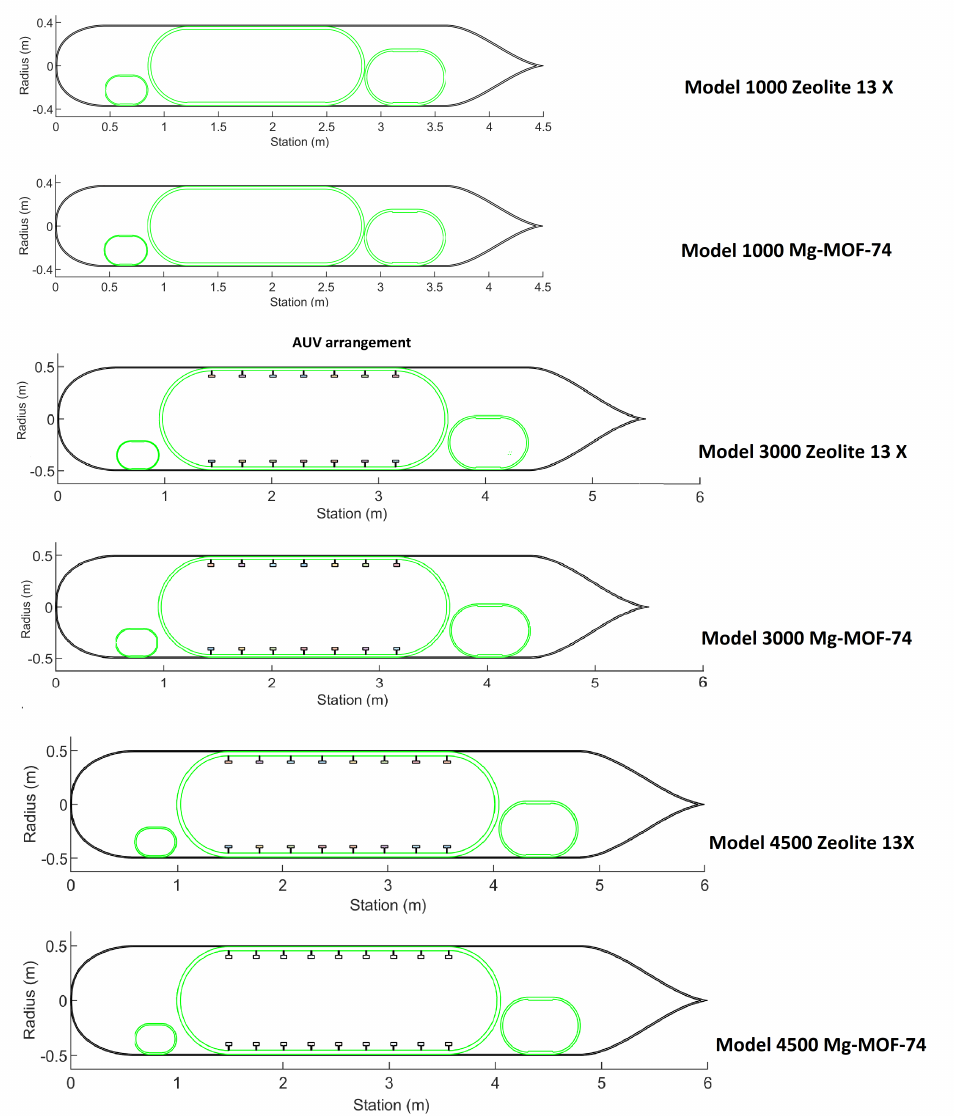
Figure 8. Sketches of the resulting Model 1000, Model 3000, and Model 4500 equipped with CO 2 CSs based on Zeolite 13X and